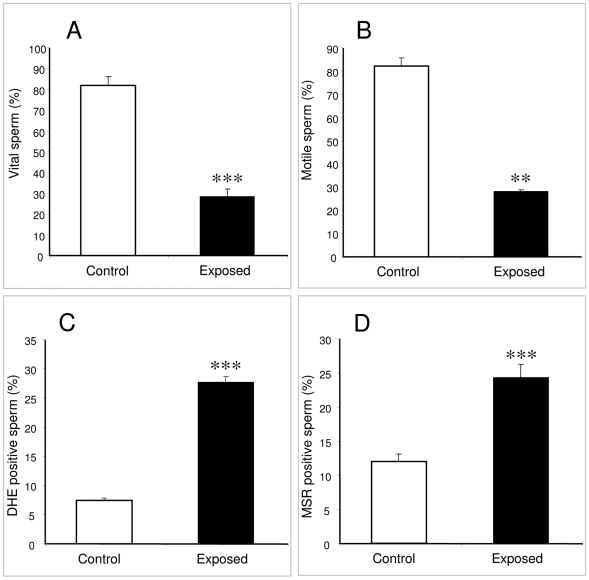
RF-EMR exposure decreases motility and vitality of human sperm while also inducing intracellular ROS.Percoll-purified spermatozoa (5×106 cells) were suspended in 1 ml BWW in a 35 mm Petri dish and placed within the waveguide while control cells placed outside the waveguide. A frequency of 1.8 GHz at a SAR of 27.5 W/kg was used and all samples were incubated for 16 h at 21°C. A, Sperm vitality was significantly reduced from the control value of 82%±4% to 29%±4% for the exposed cells (***p<0.001). B, Sperm motility was also significantly reduced from the control value of 82%±4% to 28%±1% (**p<0.01). C, ROS production was increased after RF-EMR exposure such that 28%±1% of the cells were producing ROS, while only 7%±0.4% of the controls contributed to ROS production (***p<0.001). D, 24%±1% of the exposed cells generated mitochondrial ROS, while the only 12%±1% of the control cells produced ROS from this source (***p<0.001). All results are based on 4 independent samples.